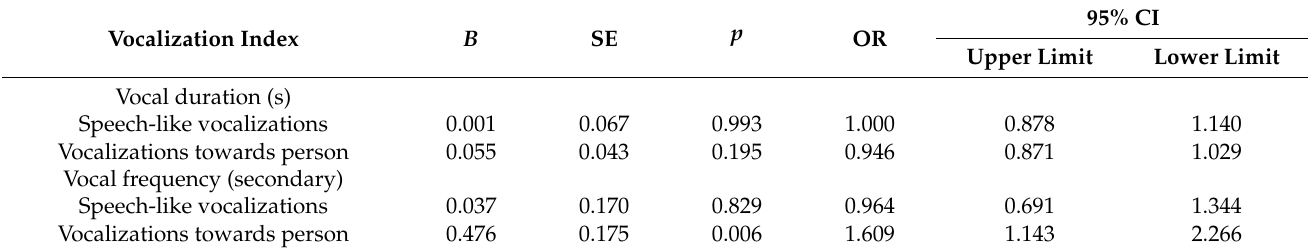
Table 4. Binary logistic regression analysis of ASD diagnosis in the still-face episode.